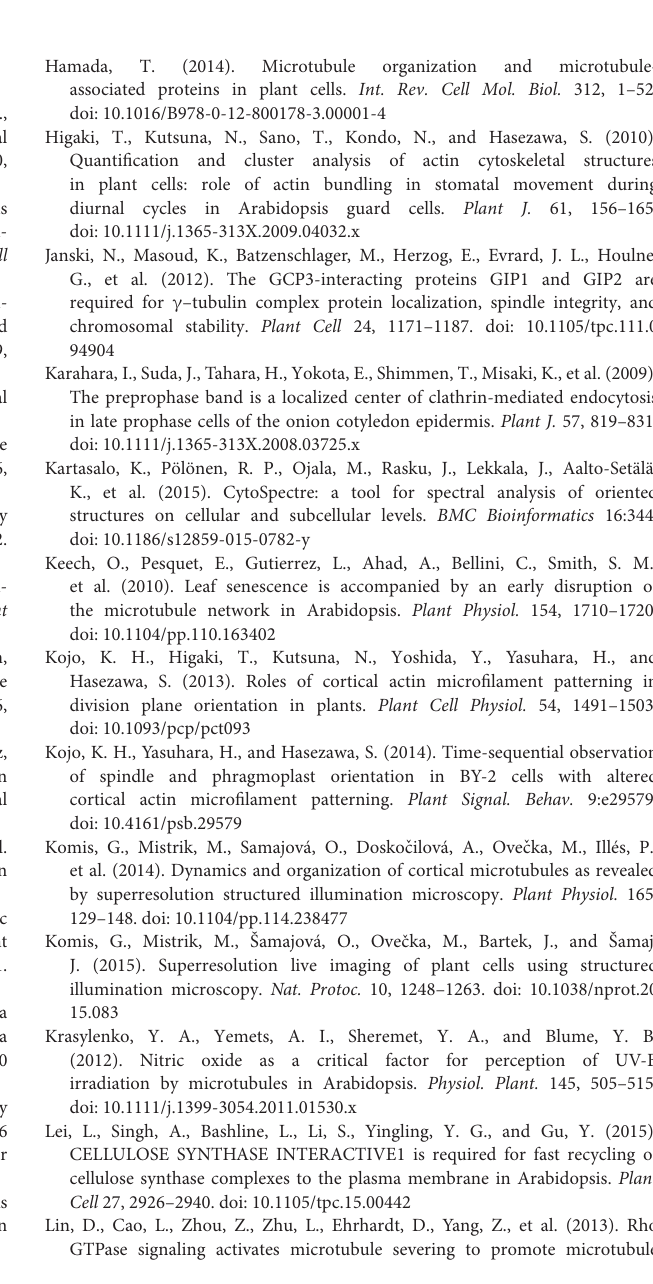
Video S3 | Panoramic 3D rendering of the cell shown in Figure 6f. Video S4 | Time lapsed series of the cell shown in Figure 7a. Video S5 | Time lapsed series of the cell shown in Figure 7b. Video S6 | Time lapsed series of the cell shown in Figure 9b (Video starts from the end of Video S5). Video S7 | Panoramic 3D rendering of the cell shown in Figure 8b. Video S8 | Time lapsed series of the cell shown in Figure 9a. Video S9 | Time lapsed series of the cell shown in Figure